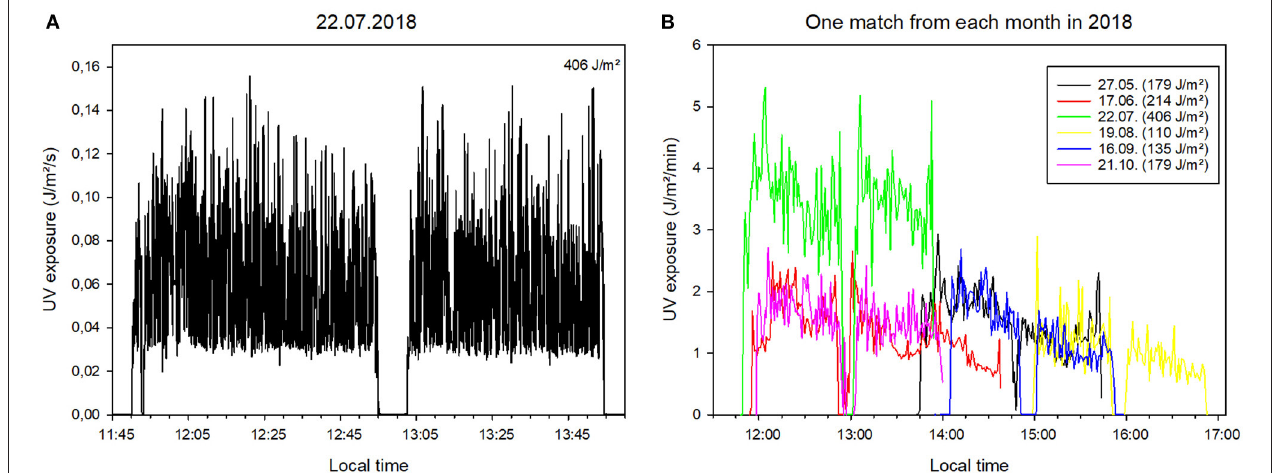
FIGURE 1 | Representation of individual measurements of UV exposure during football matches. (A) UV exposure over time for a selected football match on 22/07/2018. Data is given in 1-s intervals. (B) Direct comparison of personal UV exposure acquired during football matches at different times of the day and during the year. Data is given in 1-min intervals for clarity.